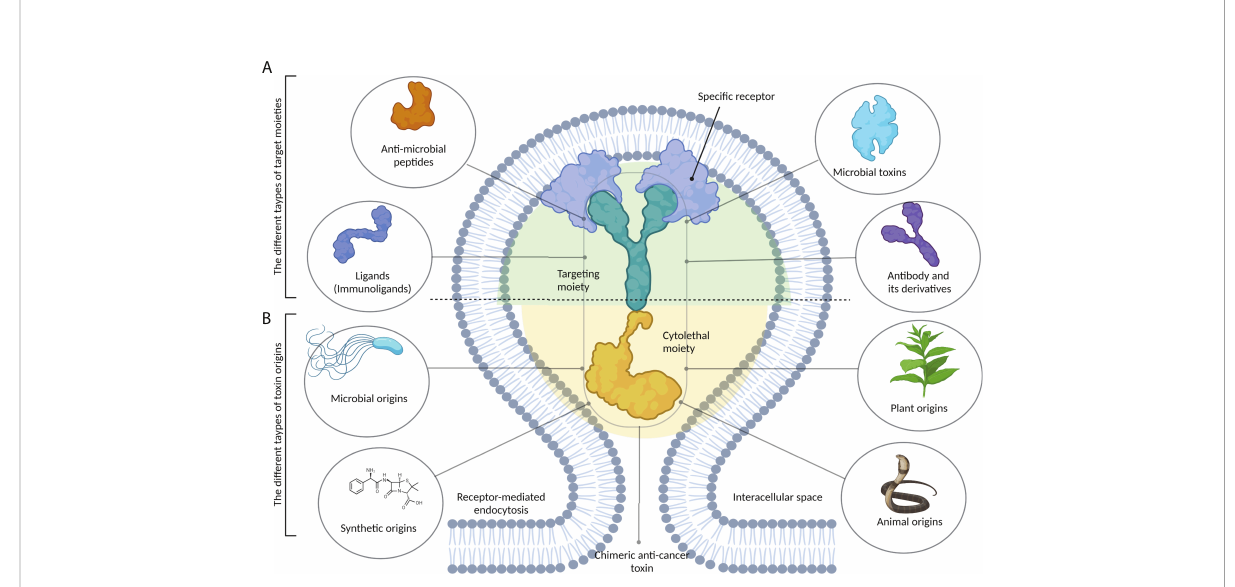
FIGURE 1 The structure of chimeric anticancer toxins (CATs). These chimeric toxins contain two distinct components. (A) A target moiety that is responsible for recognizing cancer-speci fi c receptors on tumor cells. This part can be derived from different types of biomolecules, including antibodies and their derivatives, microbial toxins, antimicrobial peptides, and immunoligands. (B) A cytolethal moiety that is responsible for killing the host cell. Chimeric toxins can be developed from the primary toxins that may be synthetic or obtained from different sources, including microbes, plants, and